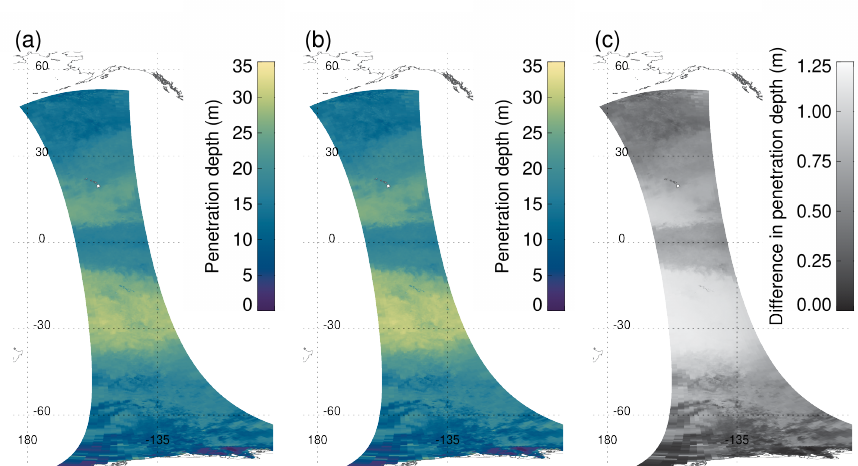
Figure 8. Maps of the penetration depths for the DNA damage dose rates: ( a ) calculated using the planar irradiance; ( b ) calculated using the scalar irradiance. ( c ) The difference between the planar penetration and scalar penetration depths. The color bars represent the penetration depths in